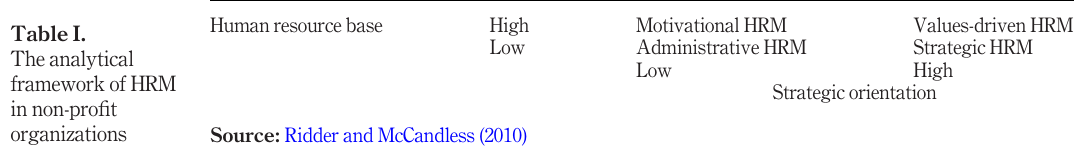
Table I. The analytical framework of HRM in non-pro fi t organizations